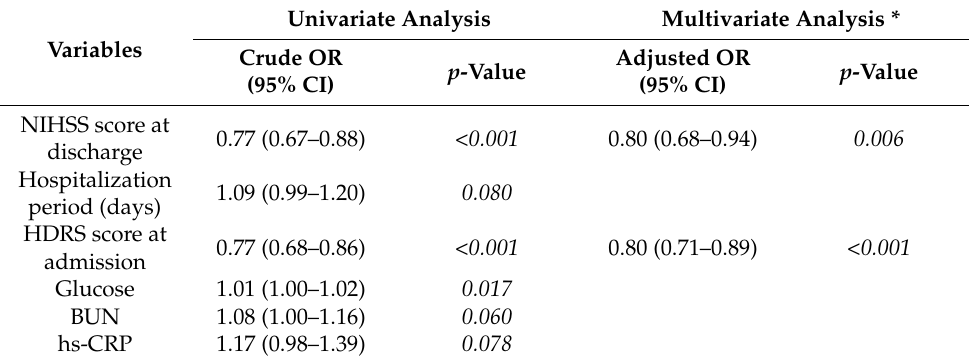
Table 4. Logistic Regression Analysis of Factors Improving Post-stroke Depression After